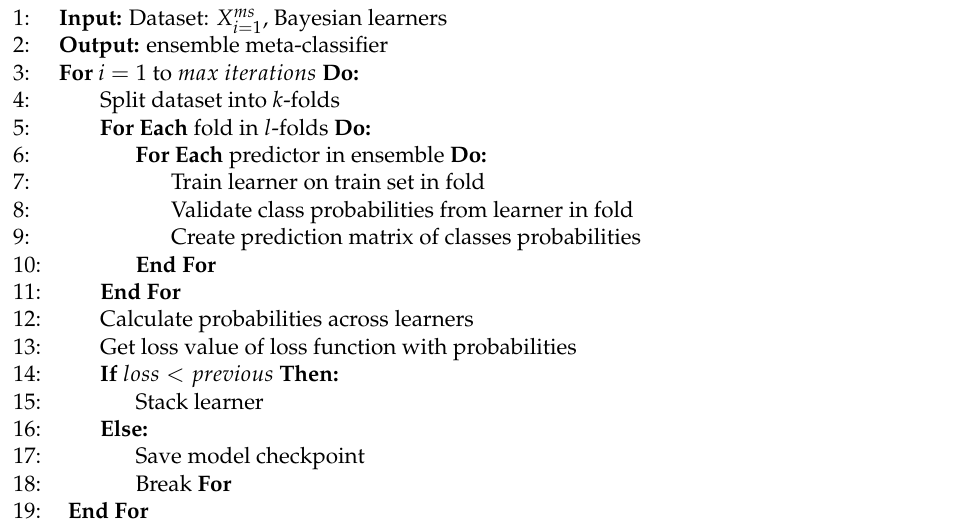
Algorithm 2 A Pseudo-code of the Proposed